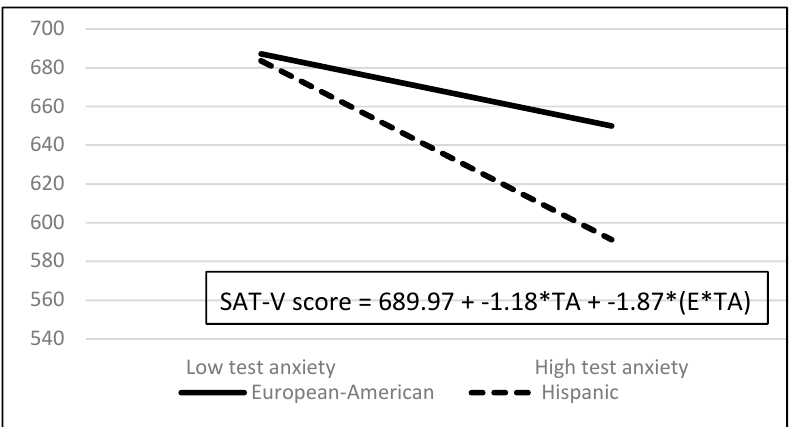
Figure 2. SAT-V scores as Function of the Test Anxiety Main Effect and the Ethnicity X Test Anxiety Interaction. TA = main effect for test anxiety and E * TA = ethnicity X test anxiety interaction.